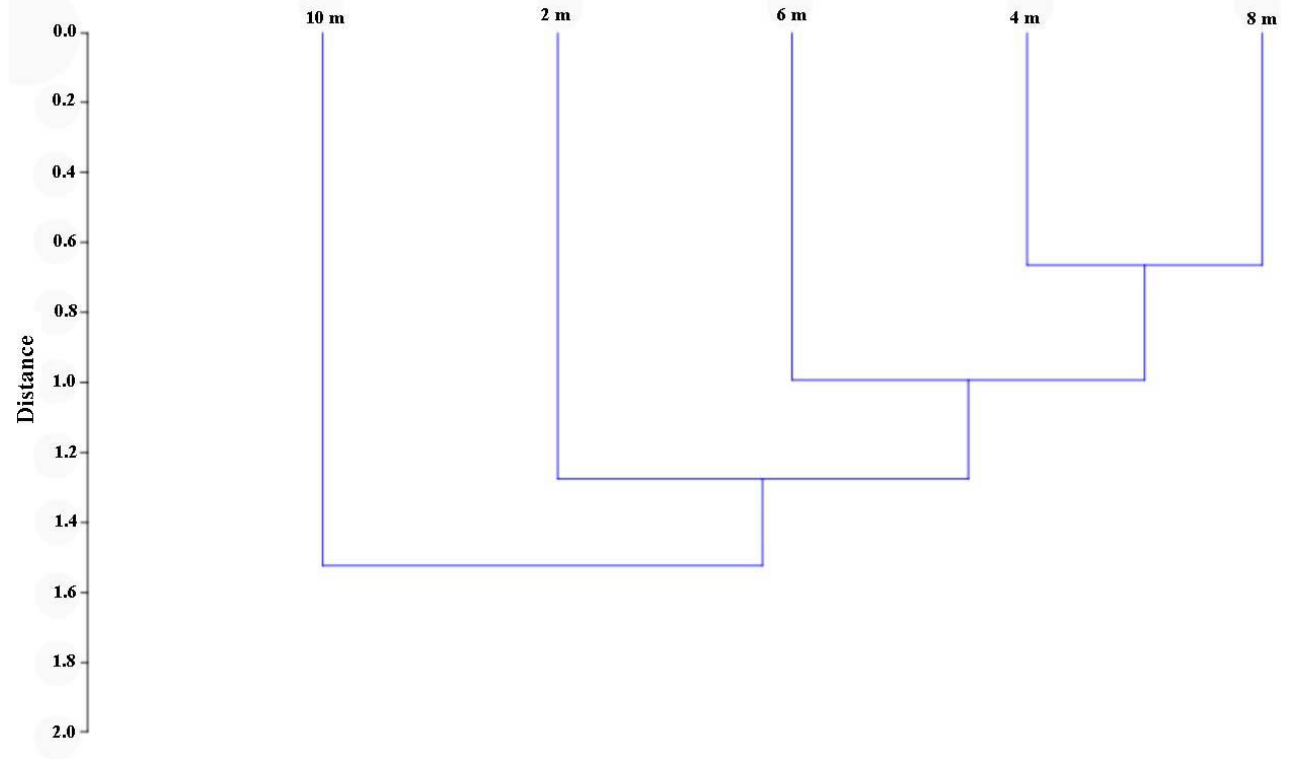
Figure 3. The insect species composition similarity for four studied heights is based on the Jaccard similarity index by using Ward's method and Euclidean distances as a measurement of Linkage Distance (cophenetic correlation coefficient = 0.690).